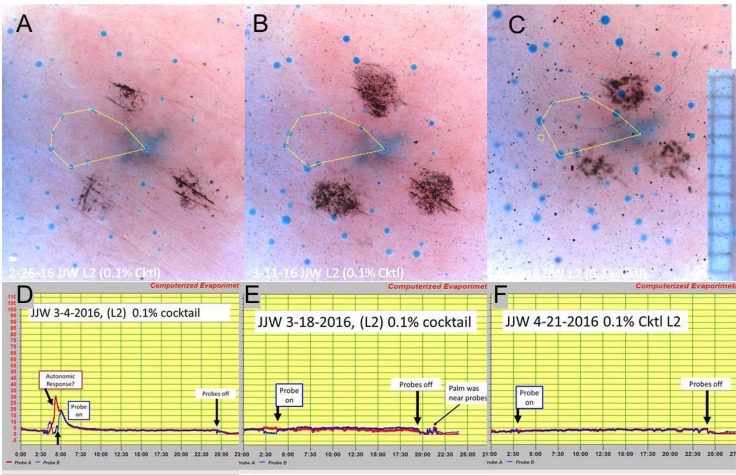
C-sweat responses at site L2 to injection of 0.1% strength cocktail measured with the bubble method and with evaporimetry.Each panel A-C shows bubble responses. (A). For this and following images, the fuzzy dark spot in the center is a tattoo to mark the spot, and the 3 surrounding dark spots are ink marks to aid focus and orientation. Eight glands are connected by the yellow dotted line to illustrate how constellations of identified glands can be followed across tests. (B) Same site as A, two weeks later. (C) Same site as A, 4 weeks later. This was the largest sweat bubble response seen out of 12 tests. Here, G93 in the marked constellation did not secrete (dotted circle) even though overall secretion was higher on this test. Grid squares on 0.5 mm. D-F show evaporimetry responses at the same site, tested one week later in each case. Probe A (red traces) are the control (not-injected site) and probe B (blue traces) are the injected site. (D). Large transient responses occurred at both sites at the time of the injection. The subject expressed alarm because the injection needle appeared close to a vein. (E, F): As for D, but 2 and 6 weeks later.